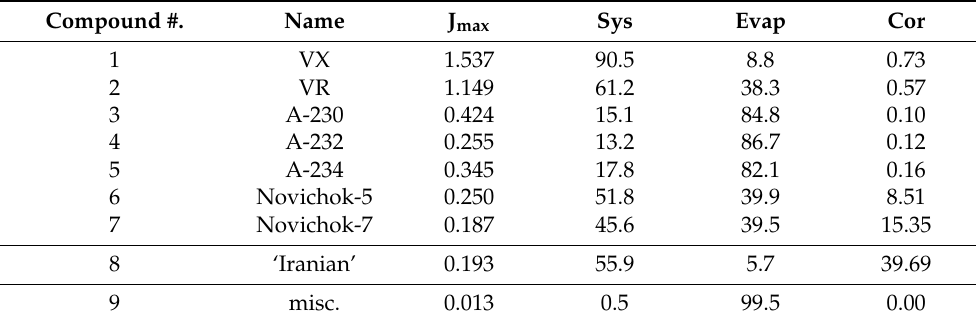
Table 3. Indicator values used for the Novichok study. Compound #.